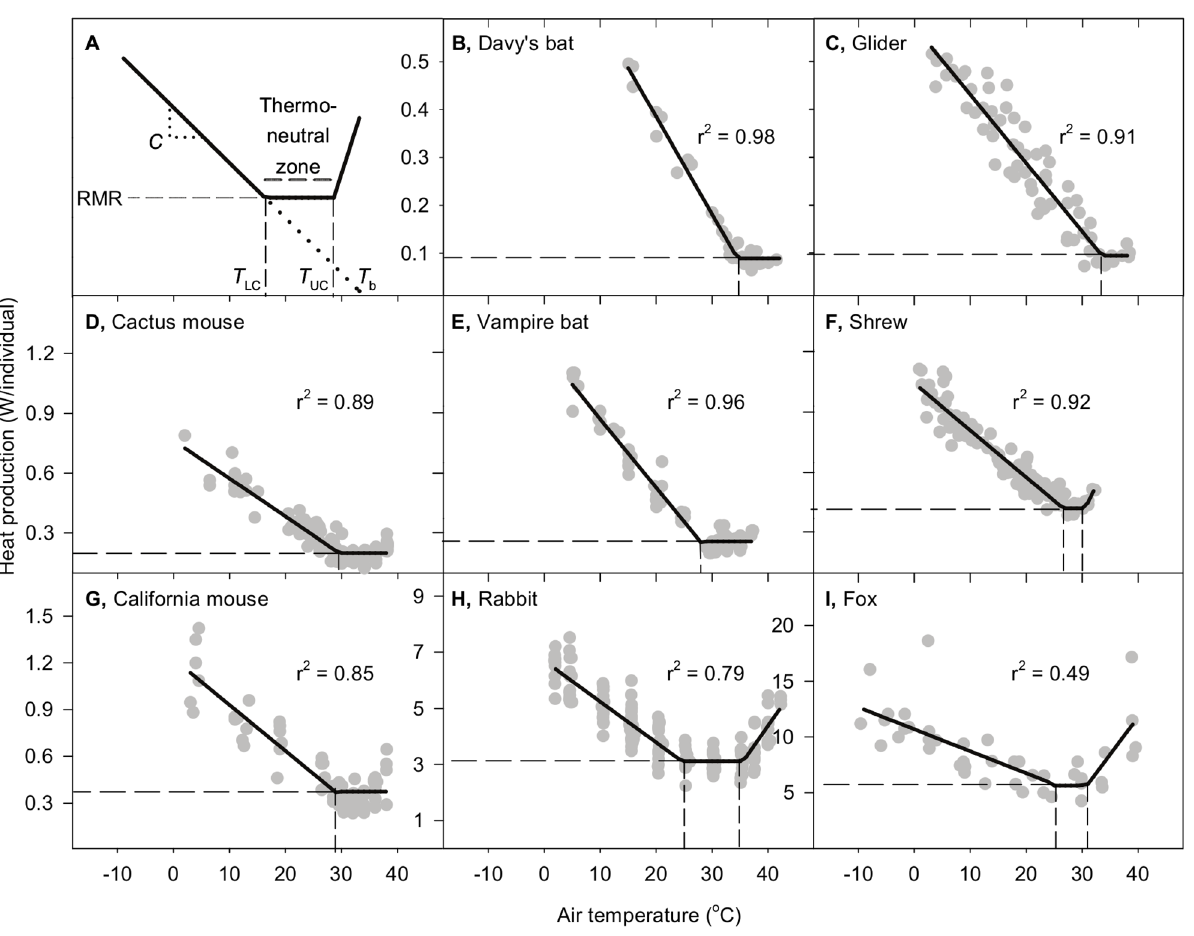
Figure 1. Rate of energy use as a function of ambient temperature ( T a ) in mammalian species: interpretive framework and examples. (A) The conventional metabolic rate- T a relation in individual homeotherms [1–2]. Within the thermoneutral zone ( TNZ ), the animal’s metabolic rate, termed its RMR , is low and independent of T a . The lower and upper limits of the TNZ are the lower ( T LC ) and upper ( T UC ) critical temperatures . Thermoregulation in the TNZ is achieved by autonomic modulation of body insulation: low near T UC but high near T LC . At T a , T LC , body insulation is approximately constant, and accordingly the rate of metabolic heat production required for thermoregulation increases as T a falls. The absolute value of the slope of this increase is conductance ( C ). Based on a first-order model, extrapolation is expected to intersect the abscissa at T a equal to body temperature ( T b ). (B-I) Metabolic rate- T a relations in eight mammal species. Each symbol represents one individual at one T a . Vertical dashed lines identify T LC and T UC where statistically defined. Horizontal dashed line identifies resting metabolic rate (RMR). Species and sources are: B, Pteronotus davyi [32]; C, Acrobates pygmaeus [33]; D, Peromyscus eremicus (Nevada) [34]; E, Desmodus rotundus [35]; F, Blarina brevicauda [36]; G, Peromyscus californicus ( parasiticus ) [34]; H, Sylvilagus audubonii (winter) [37]; I, Vulpes macrotis (winter)